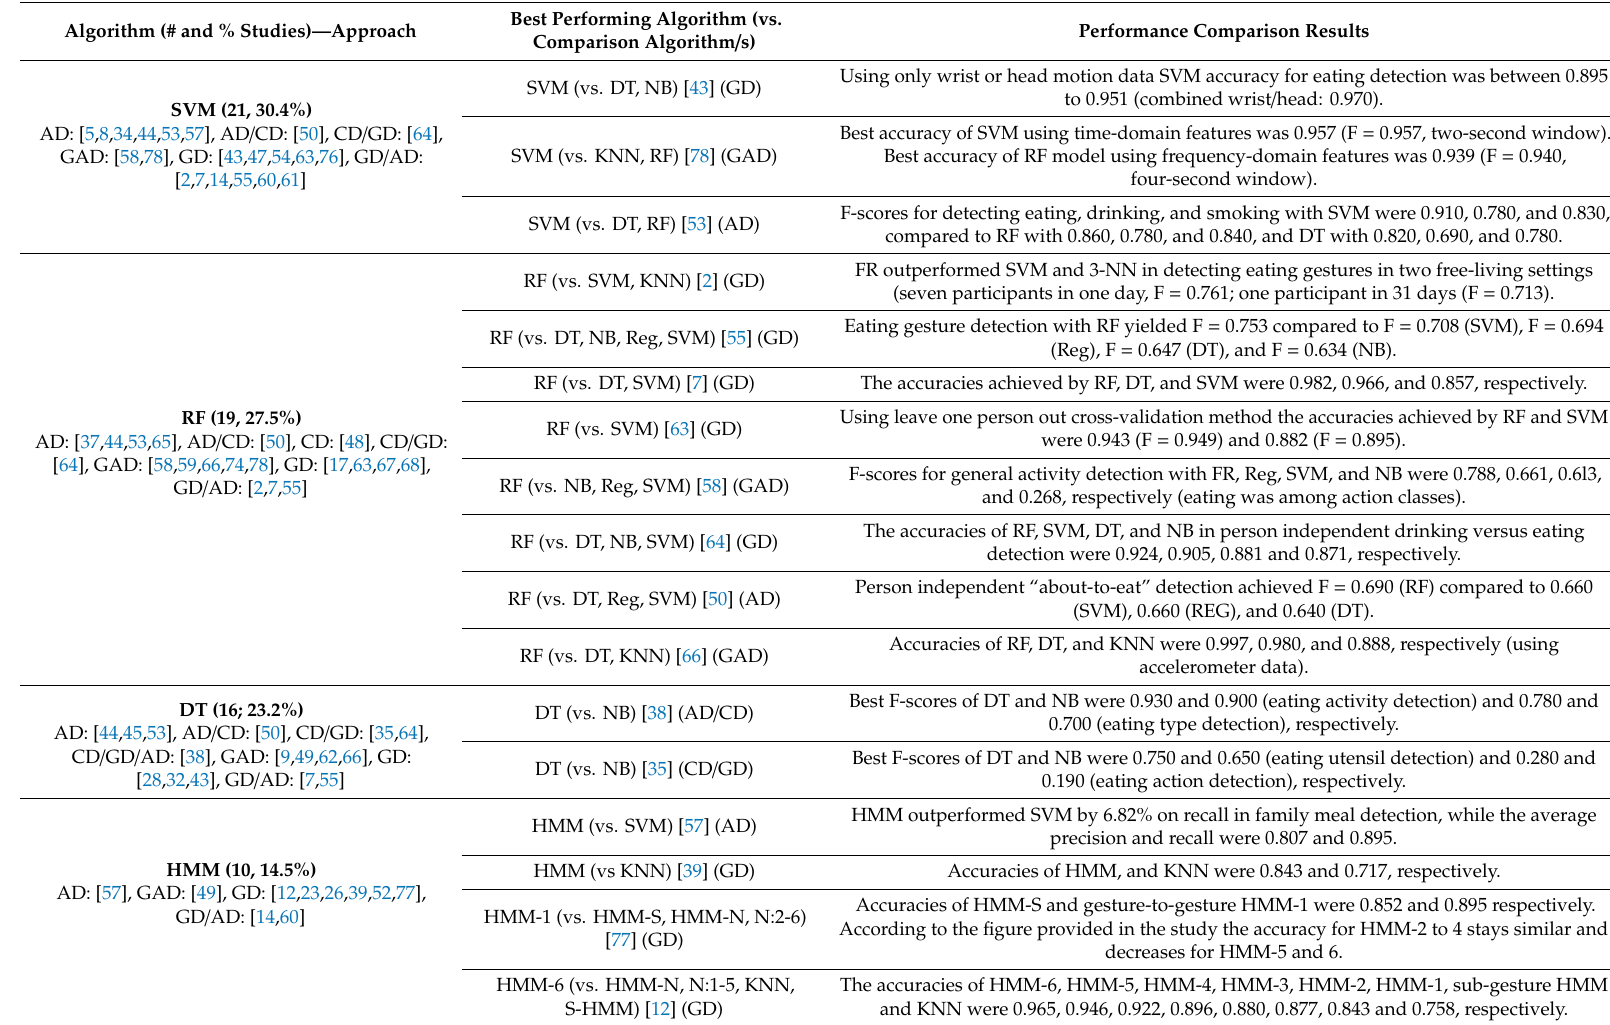
Table 3. Machine learning algorithms used in the included studies as well as and detection approaches and performance comparisons conducted in the studies. Best Performing Algorithm (vs. Algorithm (# and % Studies)—Approach Comparison Algorithm /